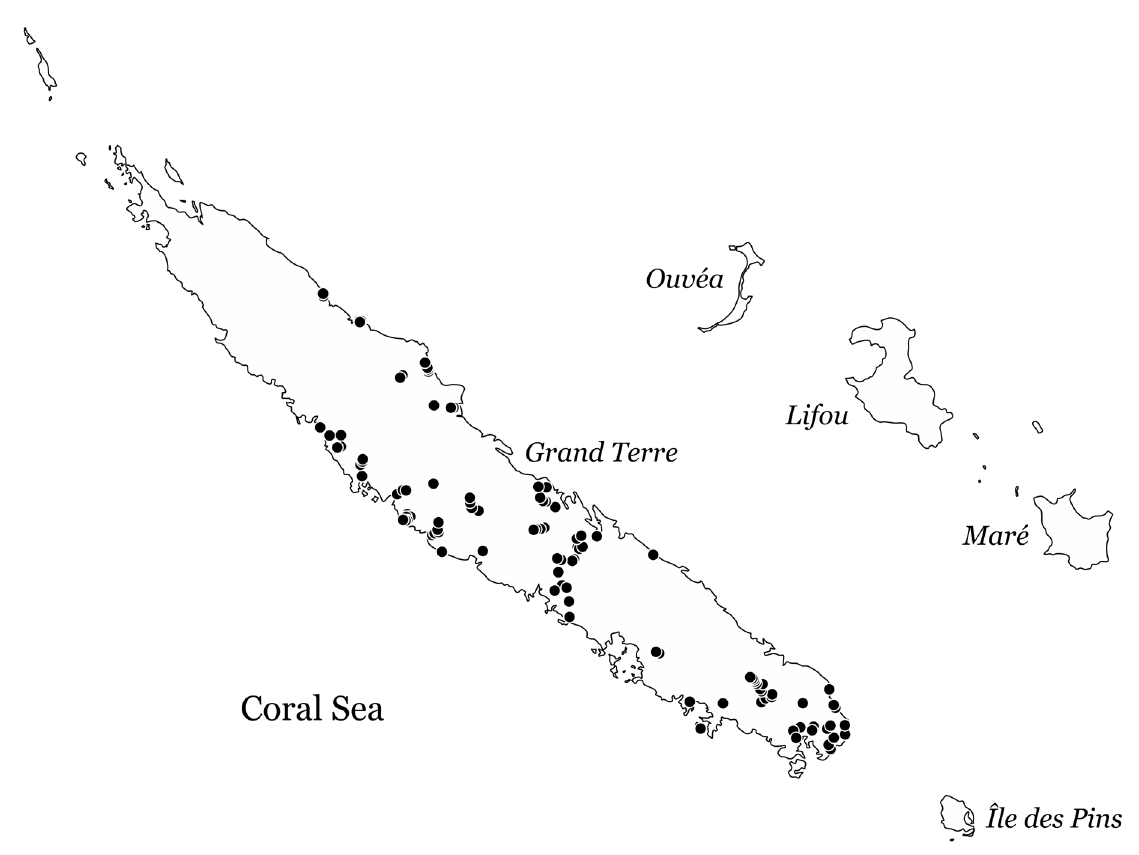
Fig. 1 . Map of New Caledonia showing approximate position of sampled locations (modified from a map file available from